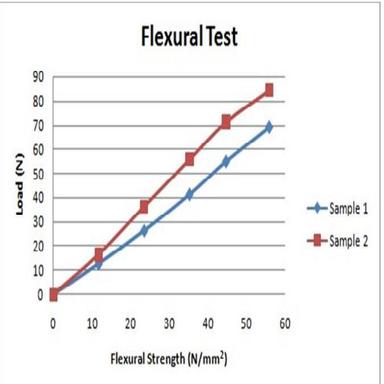
oad Vs Flexural Strength (Flexural Testing)